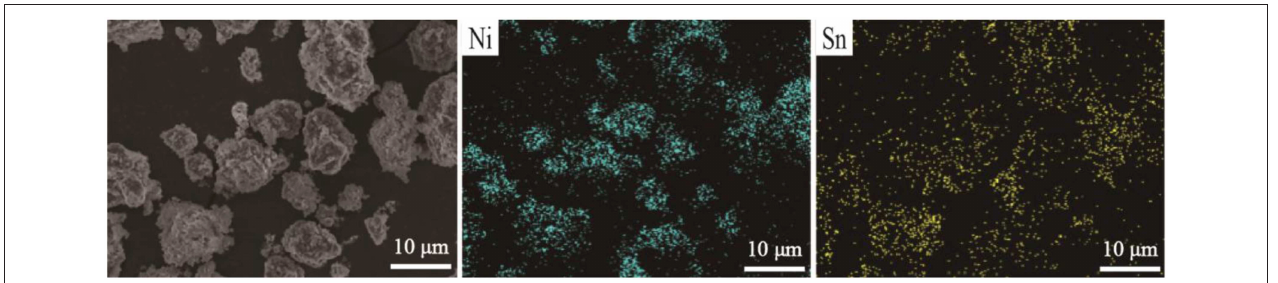
FIGURE 3 | EDS maps of the 3 wt % SnO 2 -modified 811 material.